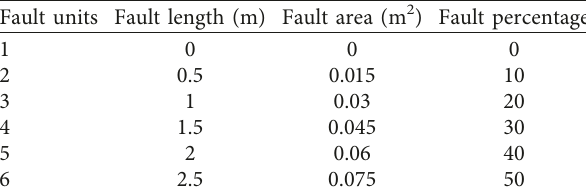
Table 2: Fault distribution in the cement asphalt layer.